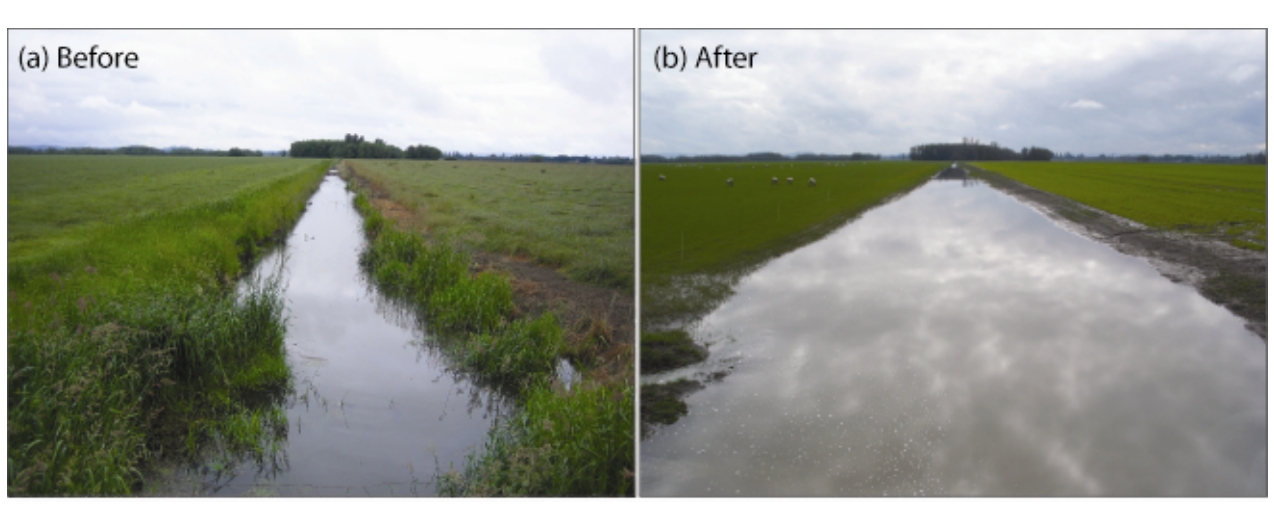
Fig. 8. Grassed waterway, pre- and post-project implementation. The objective was to eliminate a narrow gully and the concentrated erosion occurring due to bare soil (a). The ground was recontoured at 10:1, thereby widening the channel, erosion fabric was installed, and vegetation development is in its first year